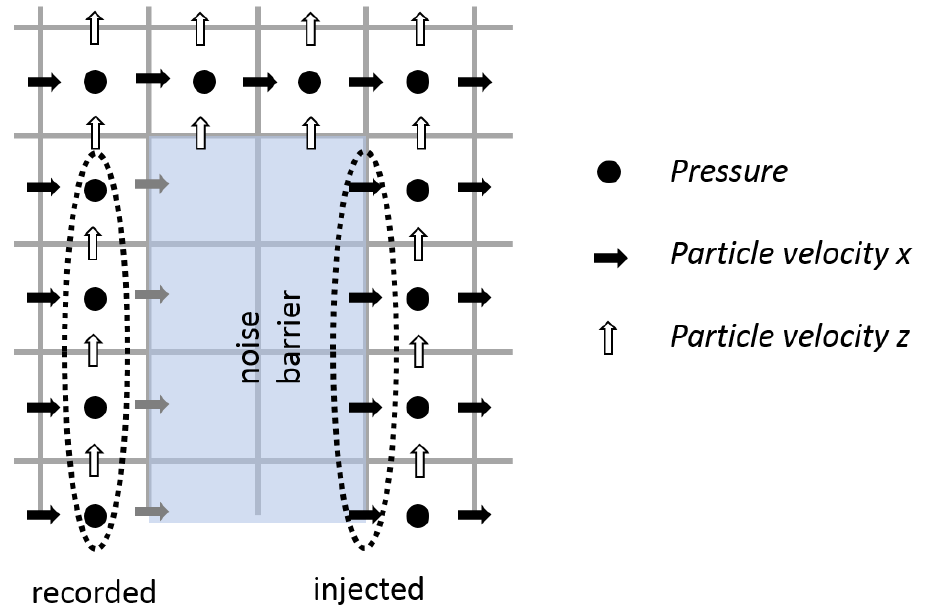
Figure 3. Schematic representation of the locations of the particle velocities and acoustic pressures grid nodes near the noise barrier in the modified FDTD simulation model, for the simulation of sound transmission through the noise barrier.